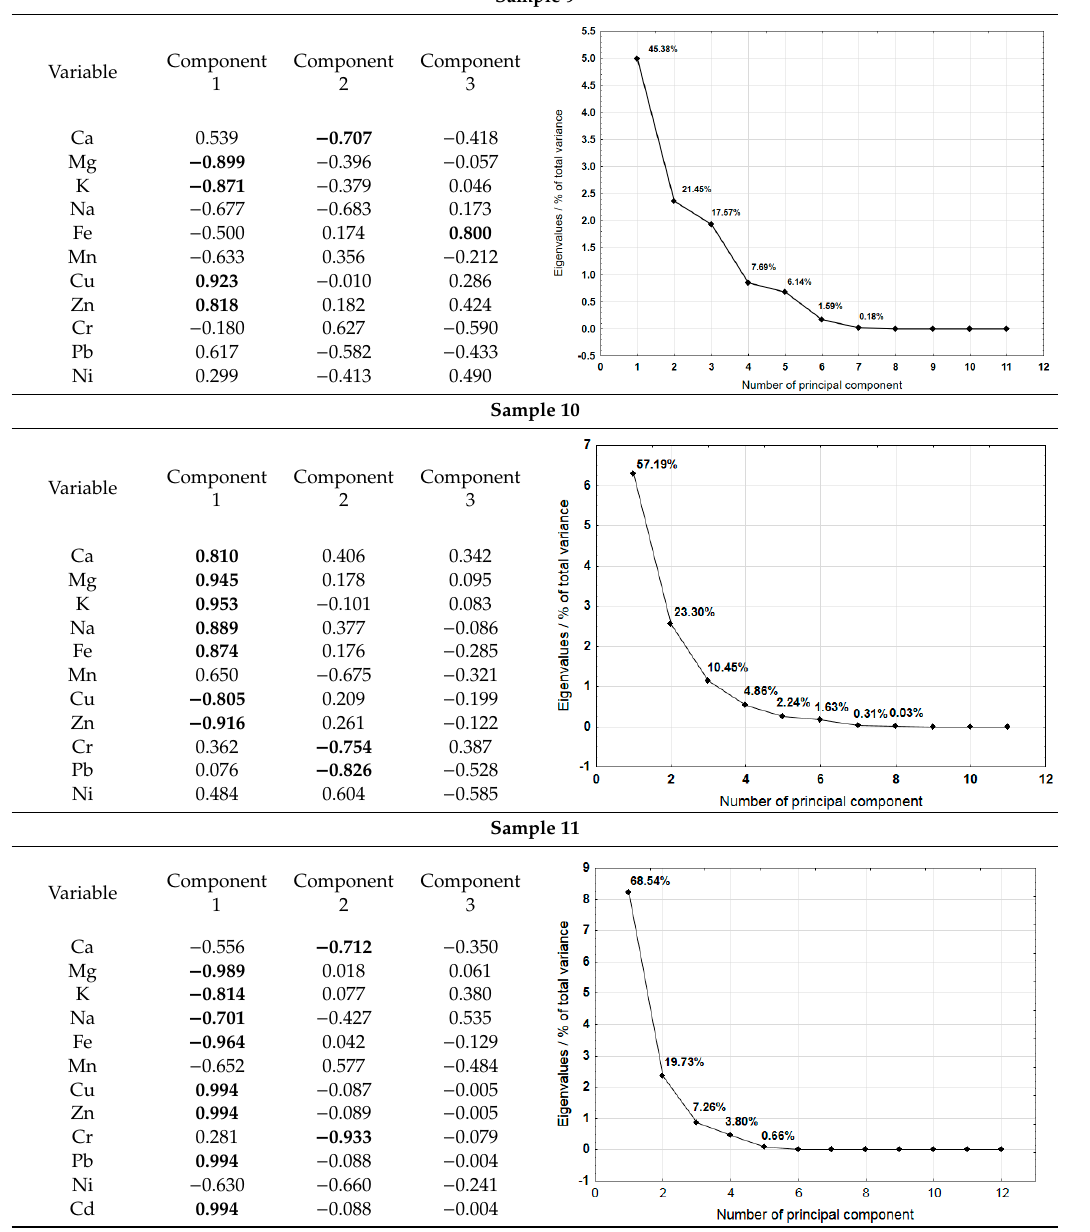
Table 9. The results of the Principal Component Analysis (PCA)for samples 9, 10, and 12. Sample 9